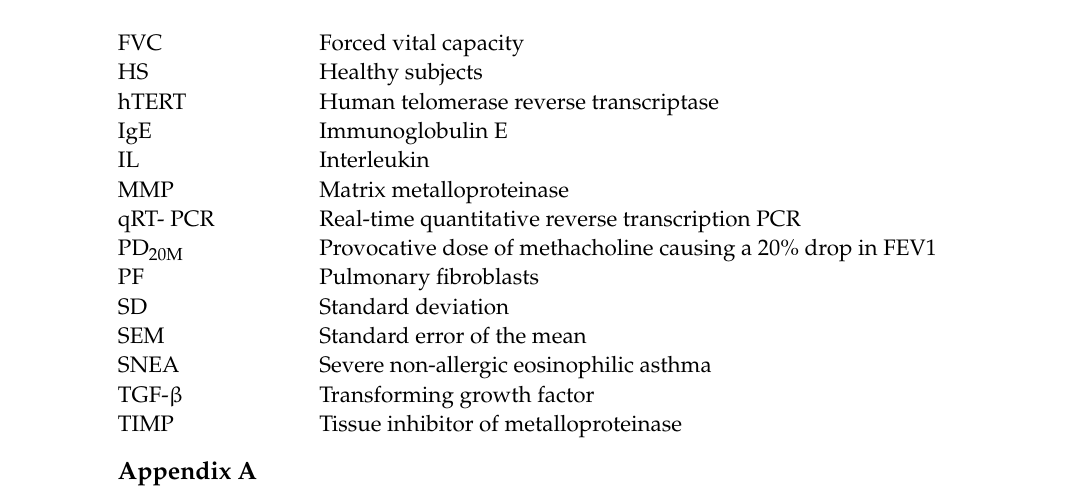
Table A1. A brief review of extracellular matrix components, their homeostasis regulatory functions, and sources.